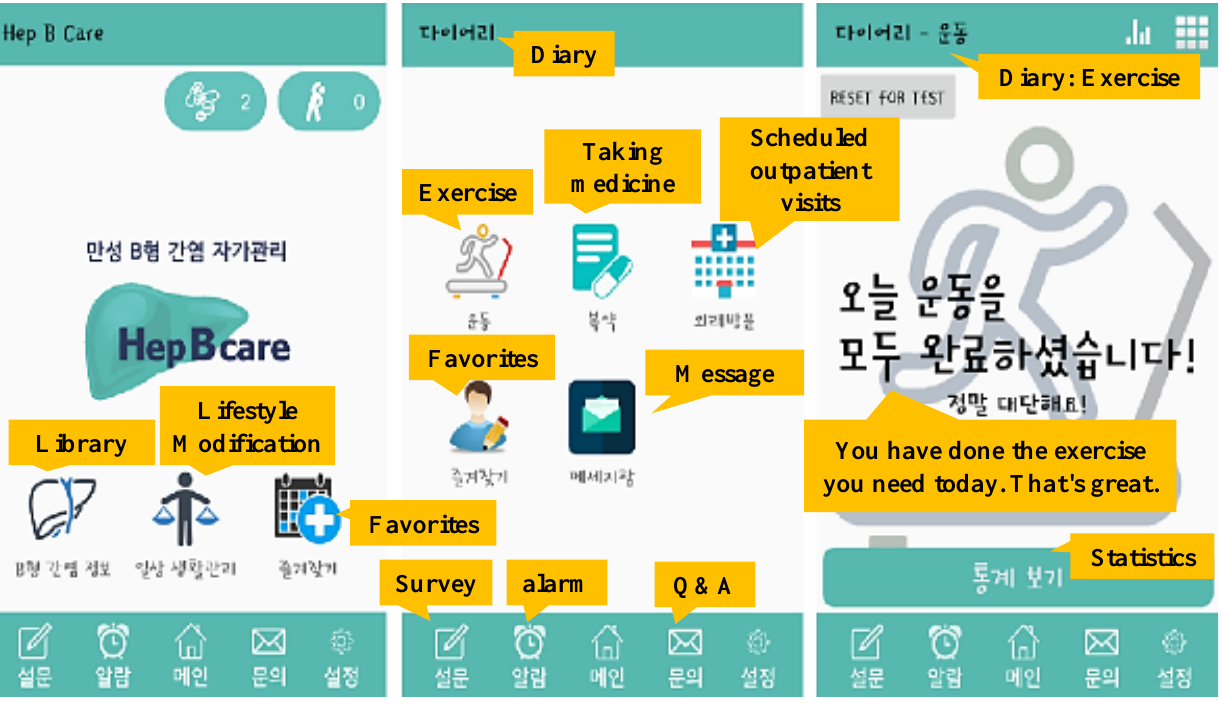
Figure 3. Images of Hep B Care ® .